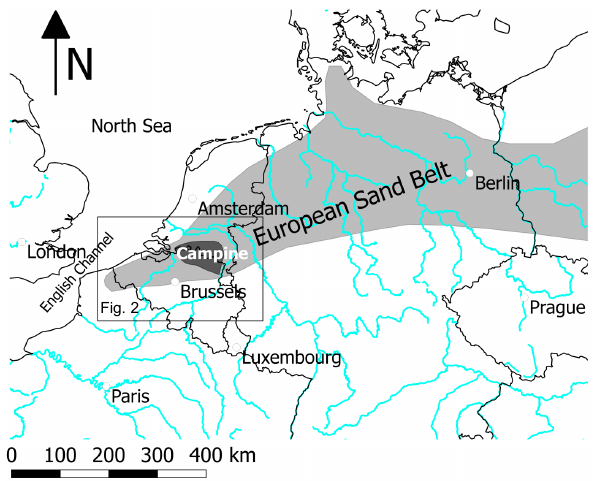
Figure 1. Location of the Campine region within Europe and the European sand belt.